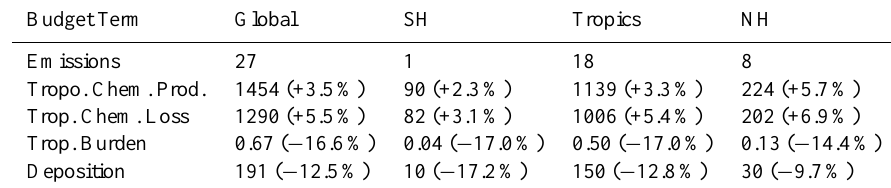
Table 3. As Table 2 but for CO and budget terms for the MBA given inTgCOyr − 1 during 2006. Budget Term Global SH Tropics NH Emissions 1162 Trop. Chem. Prod. 1314 (+10.0%) Tropo. Chem. Loss 2259 (+5.6%) Trop. Burden